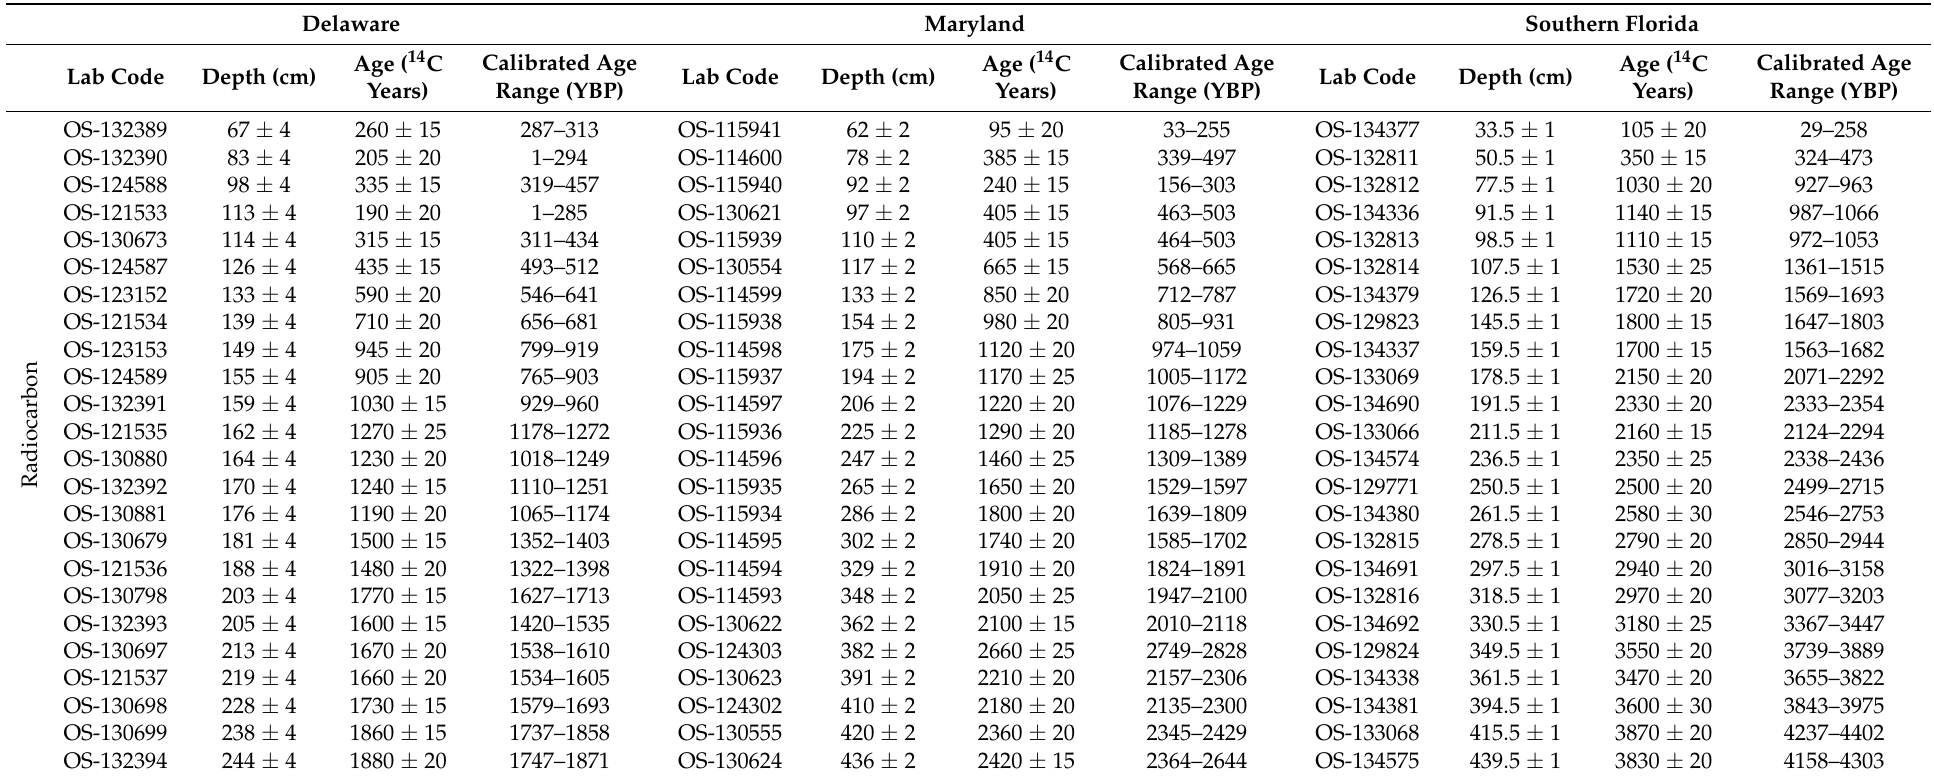
Table 2. Chronological data for unpublished sites. UMV refers to lead (Pb) pollution originating from the Upper Mississippi Valley. Core date refers to the year that the core was collected. Years before present is abbreviated as YBP with “present” defined at